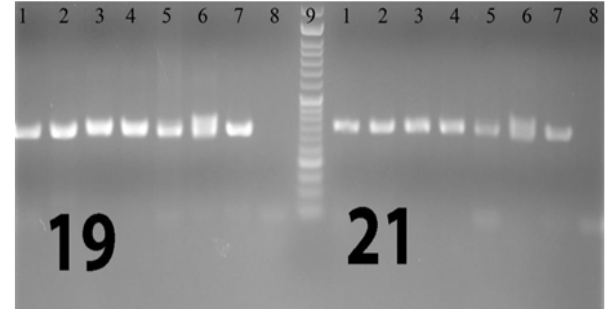
Figure1 . Visualized product on electrophoresis gel for simple PCR (first run) of exons 18 and 20 1: Ladder 2: Negative control 3, 4, 5, 6: Patients